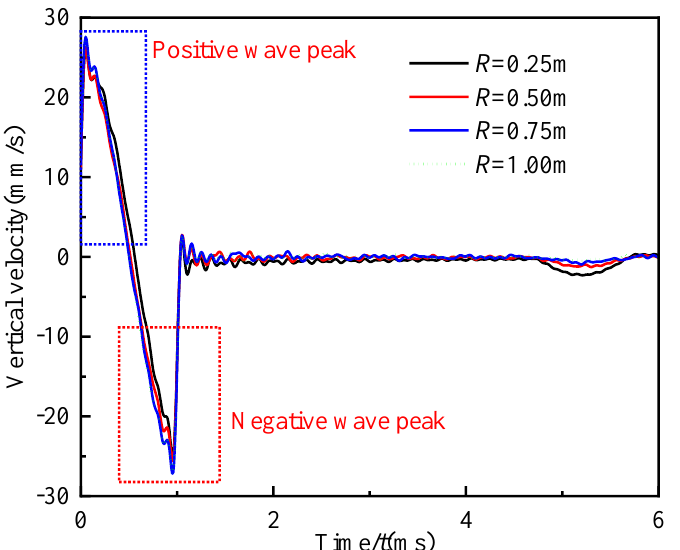
Figure 9. Vertical velocity time histories at the edge of the excitation region for different pile radii.